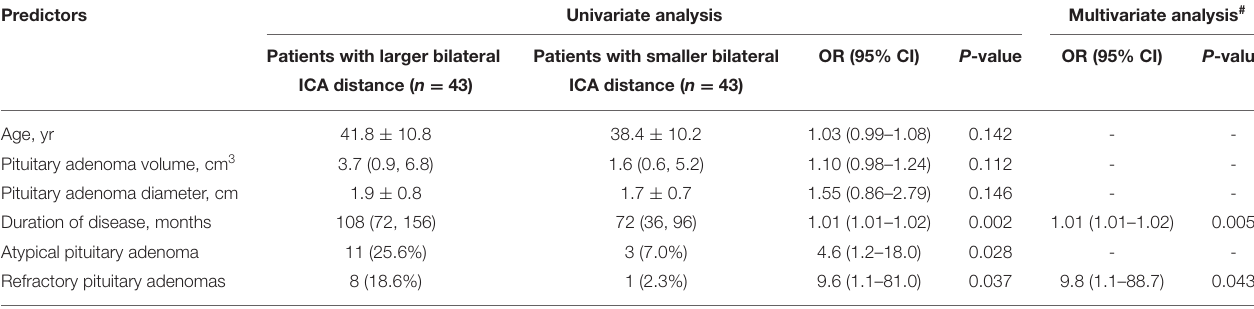
TABLE 3 | Logistic regression model analysis of larger bilateral ICA distance in acromegaly with possible factors *